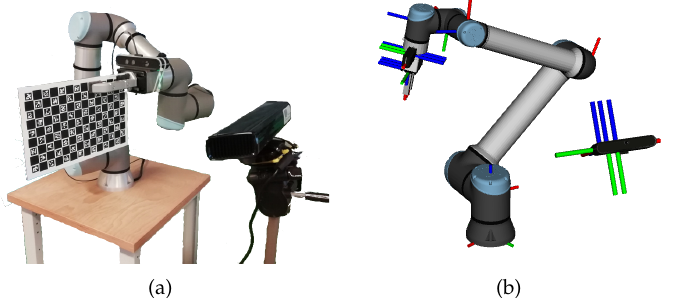
Figure 14. AgRob V16 is an Automated Guided Vehicle (AGV) used for agronomic purposes. It consists of a 3D LiDAR and a stereo camera system. ( a ) represents the real system and ( b ) represents the simulated system. Figure 15. Iris UR10e is a robotic system comprised of a robotic manipulator with two RGB cameras,